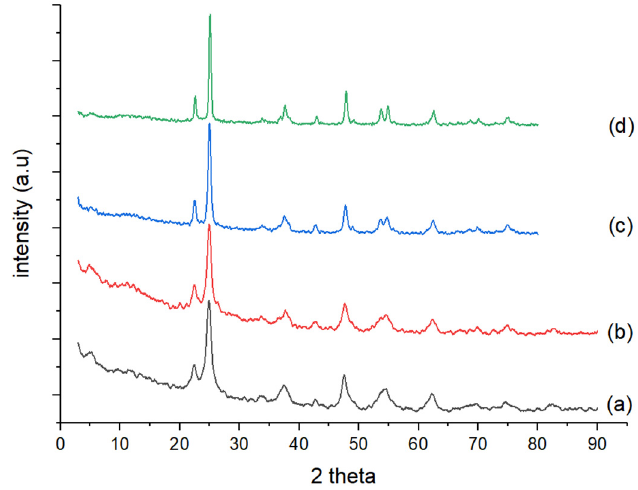
Figure 3. Diffractogram of ( a ) TS0, ( b ) TS-3-400, ( c ) TS-3-500, and ( d ) TS-3-600.